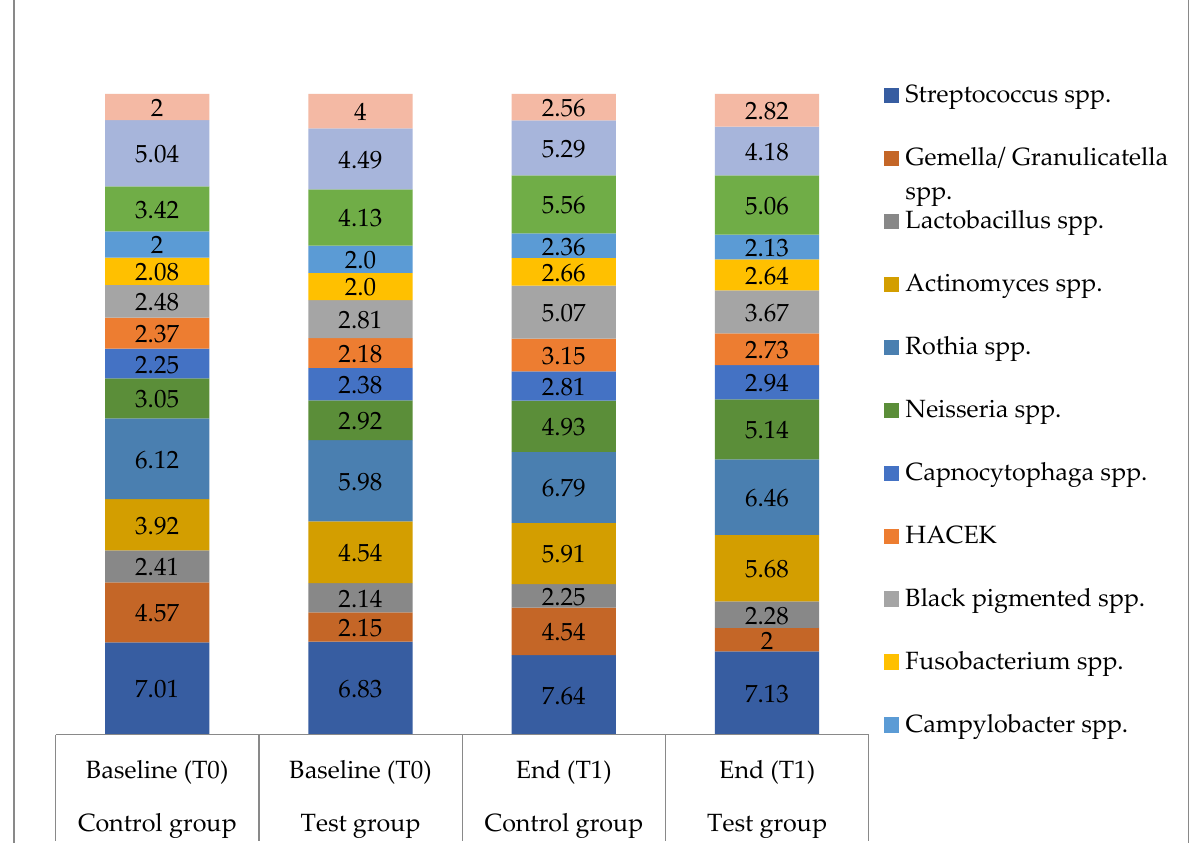
Figure 4. Microbial composition of saliva samples in Log 10 CFU/mL. Bacterial counts of bacterial species for the test group and the control group at baseline (T0) and after 36 months (T1); values are given as means in log 10 CFU/mL; spp. = species pluralis, HACEK = Haemophilus spp., Aggregatibacter actinomycetemcomitans , Aggregatibacter aphrophilus , Cardiobacterium hominis , Eikenella corrodens , Kingella spp.; n = 16 for each group.